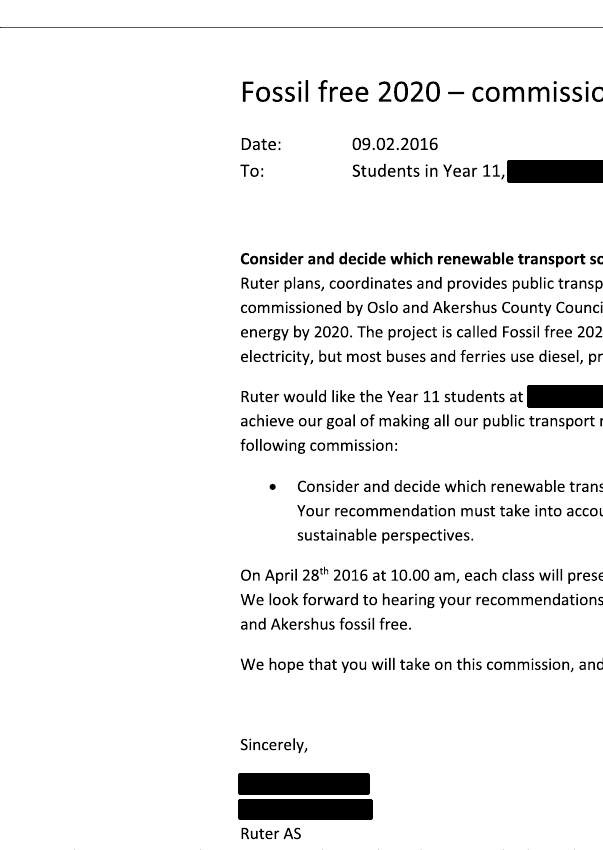
Fig. 2 The commission letter given to the students by Ruter (the letter has been translated and